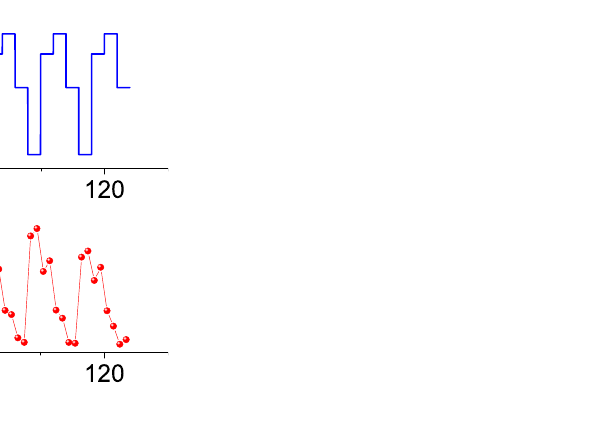
Figure 7. WRER test for the ITO/PS + GO/Al